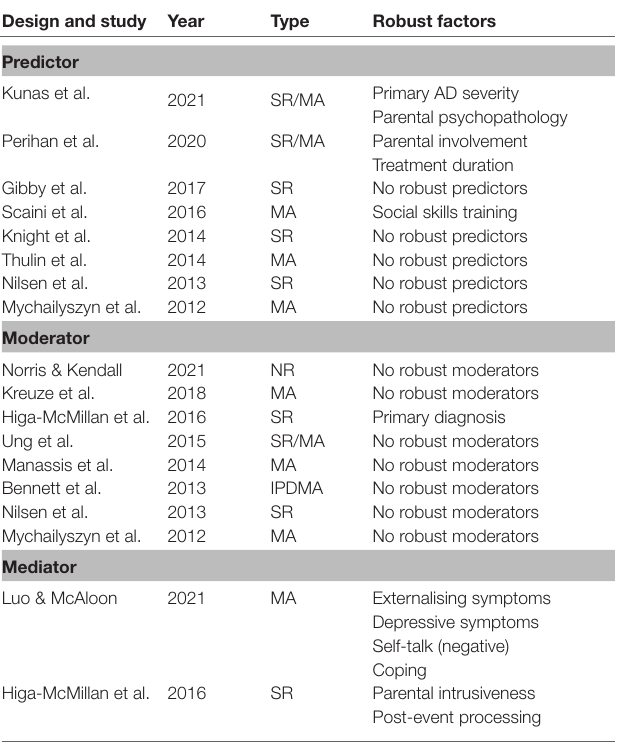
TABLE 1 | Summary of predictors, moderators and mediators of CBT